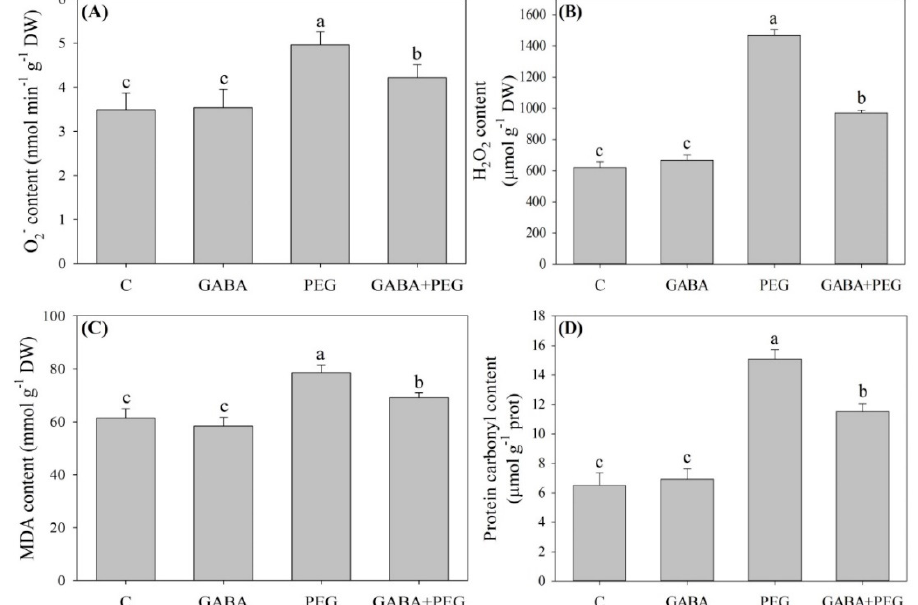
Figure 3. Effects of exogenous γ -aminobutyric acid (GABA) pretreatment on ( A ) superoxide anion (O 2 − ) content, ( B ) hydrogen peroxide(H 2 O 2 ) content, ( C ) malondialdehyde (MDA) content, and ( D ) protein carbonyl content in leaves of creeping bentgrass under non-stress and water stress conditions. Vertical bars indicate ± SE of mean ( n = 4). Different letters above columns indicate significant difference based on the LSD ( P ≤ 0.05). C, well-watered control; GABA, well-watered control pretreated with GABA; PEG, PEG-induced water stress; GABA + PEG, water-stressed plants pretreated with GABA.